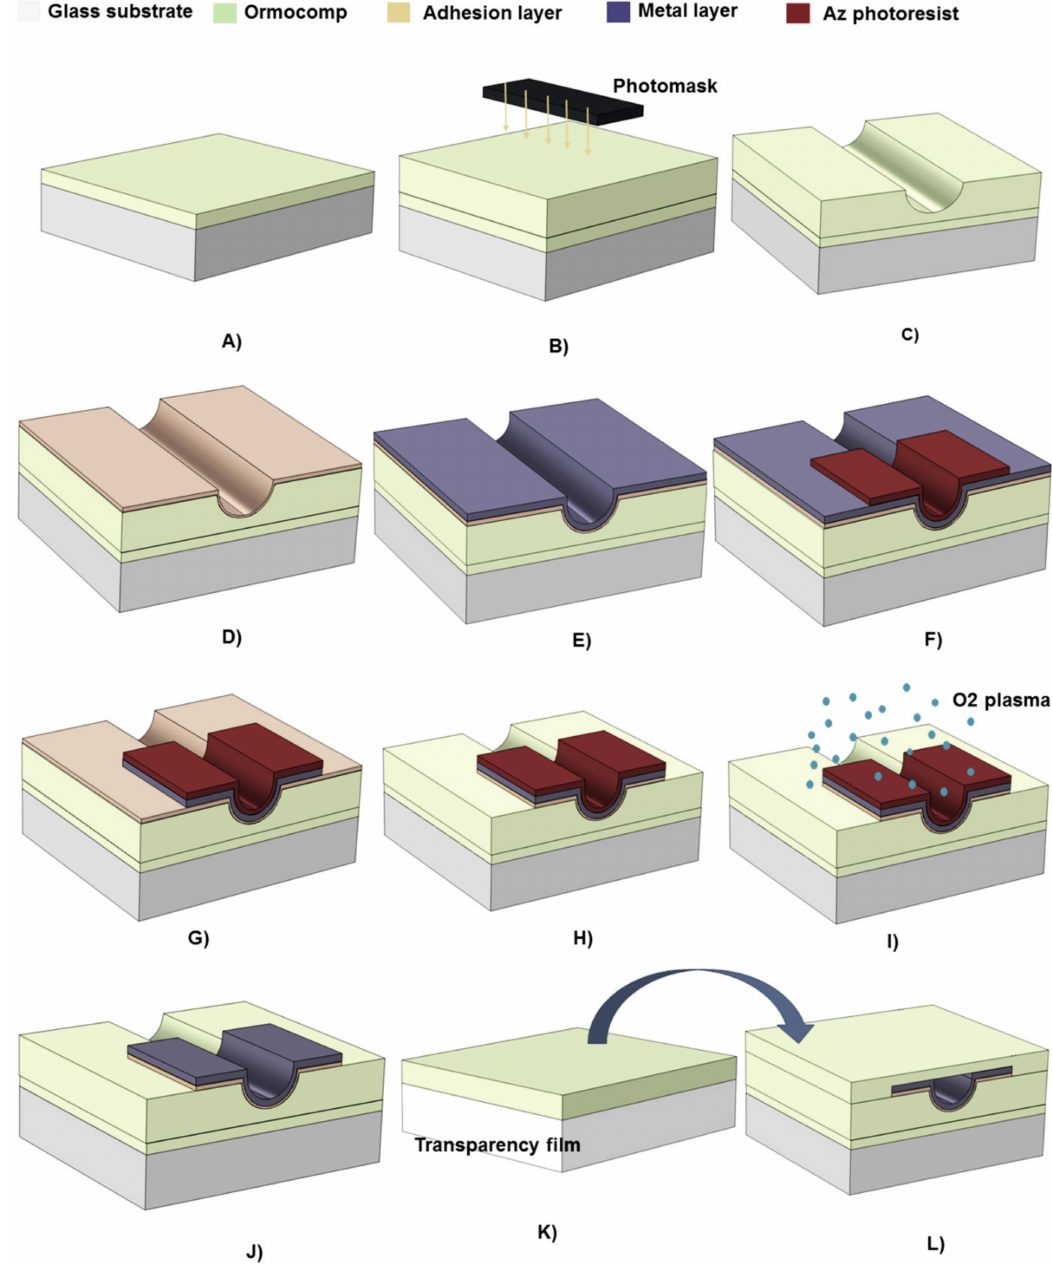
Figure 1. Schematic presentation of the photolithographic fabrication and metallization of concave Ormocomp microchannels: ( A ) spincoating and flood exposure of the first (bottom) layer of Ormocomp, ( B ) spincoating and masked exposure of the second (microchannel) layer, ( C ) Ormocomp development and hard bake, ( D ) deposition of the adhesion layer (17 nm Cr or 5 nm Ti), ( e ) deposition of the metal layer (Ag, Au, Al, or Pt) and hexamethyldisilazane coating, ( F ) spincoating and patterning of the photoresist, ( G ) etching of the metal layer, ( H ) etching of the adhesion layer, ( I ) oxygen plasma treatment, ( J ) photoresist removal, ( K ) spincoating and flood exposure of the third (bonding) layer of Ormocomp on a transparency film, and ( L ) adhesive bonding over the metallized